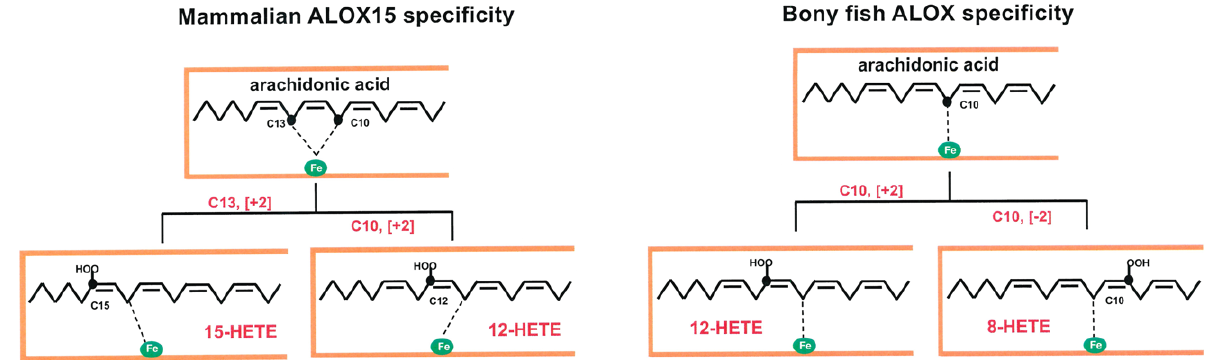
Figure 9. Bony fish ALOX isoforms exhibit a different kind of dual reaction specificity when compared with mammalian ALOX15 orthologs. Mammalian ALOX15 orthologs catalyze initial hydrogen abstraction from two different bisallylic methylenes (C 13 and C 10 of AA) and the fatty acid radical undergoes [+2] radical rearrangement. Thus, 12- and 15-HETE are simultaneously formed. Bony fish ALOX-isoforms catalyze hydrogen abstraction from a single bisallylic methylene (C 10 ), but the fatty acid radical formed rearranges in opposite directions ([+2] and [−2]).